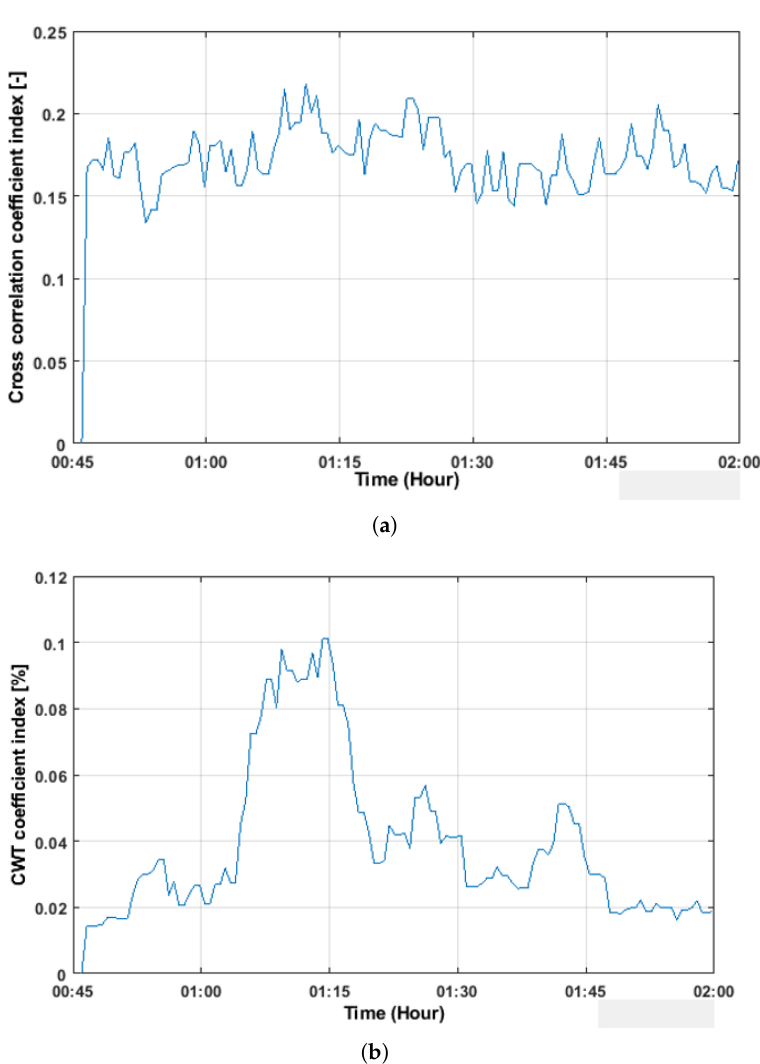
Figure 14. Values of both coefficient indices from the sensor pair S02R08. ( a ) Cross-correlation coefficient index from the sensors pair S02R08 in the Gliwice bridge; ( b ) CWT coefficient index from sensors pair S02R08 in the Gliwice